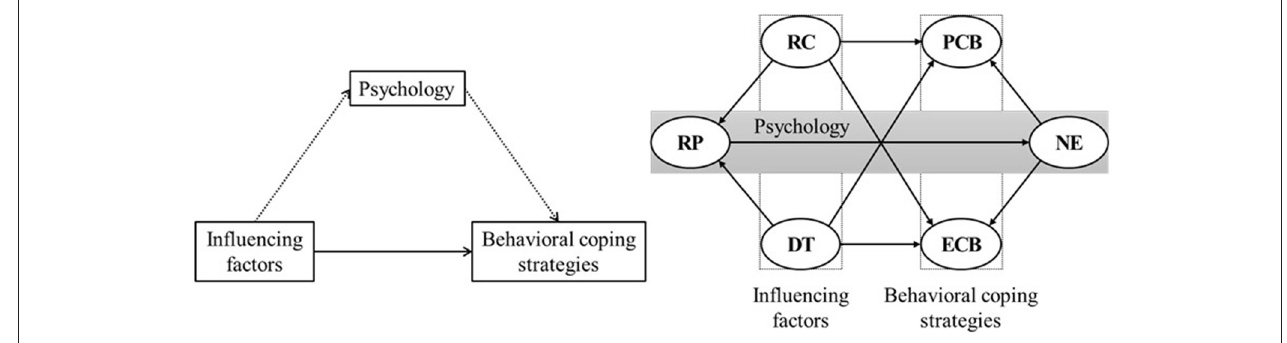
FIGURE 1 | Structural equation model hypothesis. RC, Risk communication; DT, degree of trust; RP, risk perception; NE, negative emotions; PCB, protective coping behavior; ECB, excessive coping